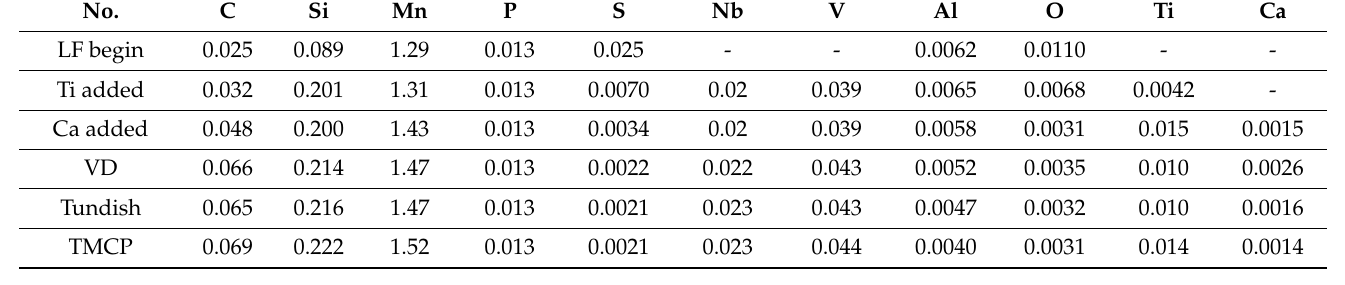
Table 1. Chemical composition of samples taken from different stages (wt%).